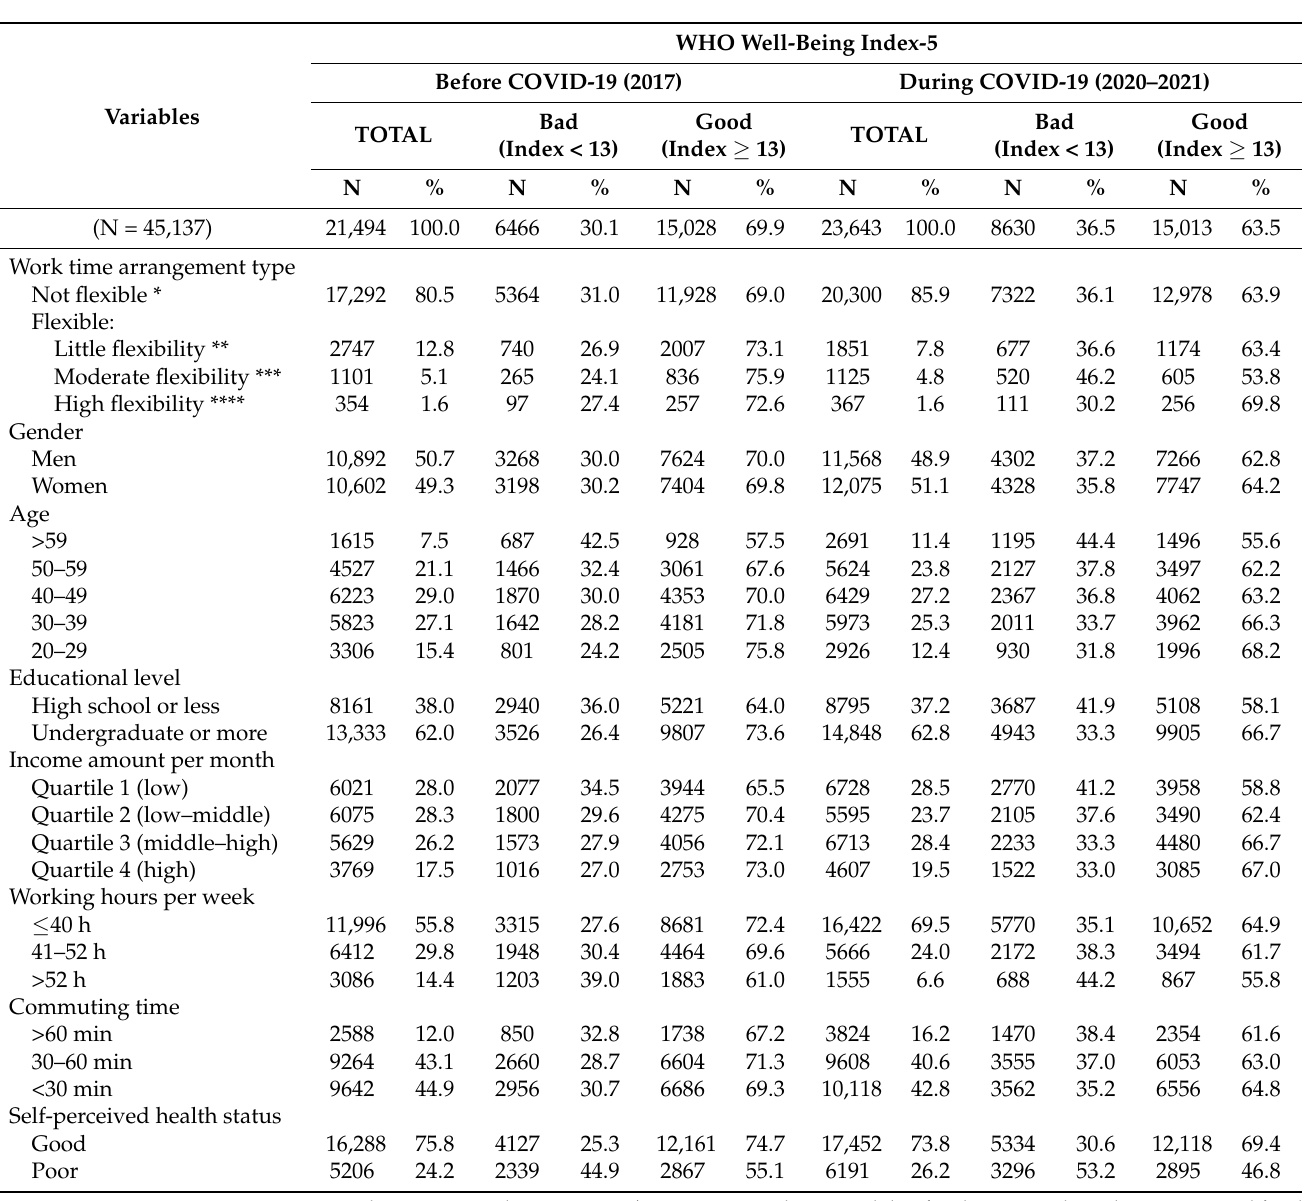
Table 1. General characteristics of the study